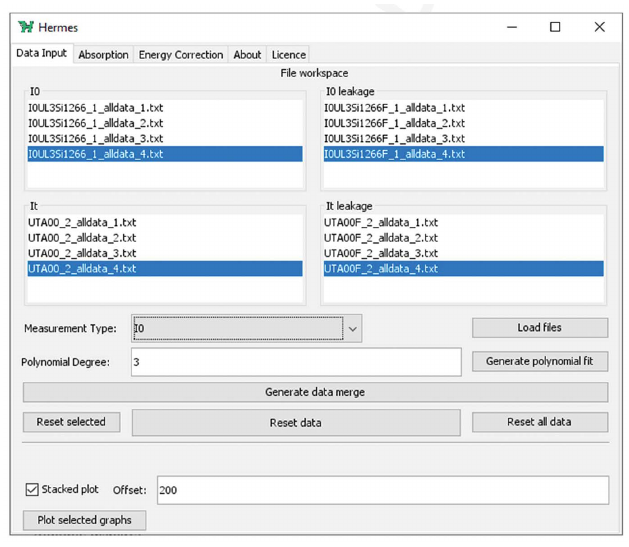
Figure 1 HERMES dashboard showing the Data Input tab, with four file workspaces, measurement type dropdown menu, data processing and plotting tools.